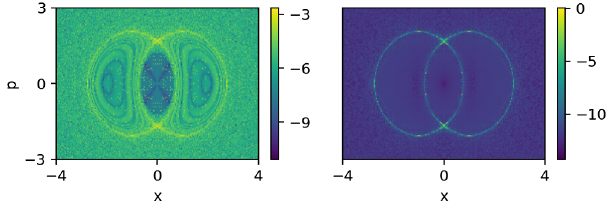
FIG. 11. Dynamic aperture plot using FMA and REM for the tune depression ratio η ¼ 0 . 8 and mismatch X ð 0 Þ ¼ 0 . 651 with the sampling period slight larger than the stroboscopic period (by 0.1%).